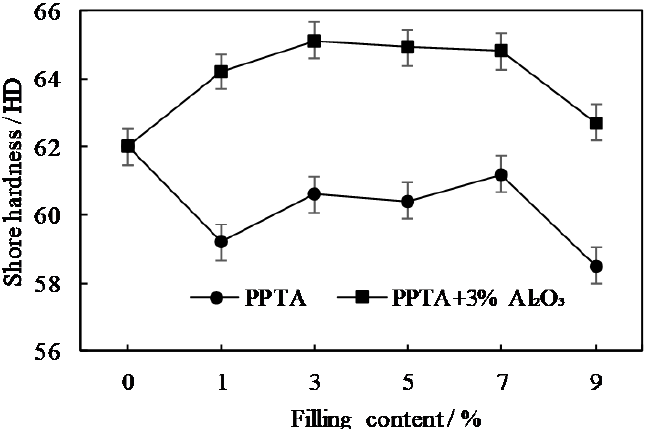
Figure 15. The hardness of PPTA and nano Al 2 O 3 particles filled modified PTFE composite material.